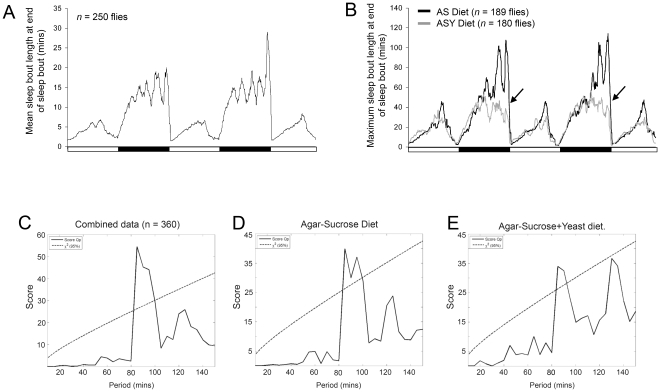
Arousal from sleep is ultradian and disrupted by dietary yeast.The time of day that a male fly aroused from a sleep bout was recorded and the length of that sleep bout was calculated and plotted as a 1-hour running average over 2.5 consecutive days. (A) Data from 250 different male flies from five independent experiments is presented. During the daytime there is no obvious ultradian rhythm of arousal, whereas at night there are several discrete epochs during which flies are more or less likely to arouse from sleep. (B) The effect of the AS (black line) and ASY (gray line) diets upon the ultradian pattern of nocturnal arousal. Data for the maximum length of sleep bouts is presented. Flies fed the AS diet show an ultradian rhythm of arousal, whereas, flies on the ASY diet have similar periodicity ultradian rhythm of arousal but lower peaks of sleep length due to shorter periods of sleep on the ASY diet (arrows). (C) Periodogram analysis of the data combined from all experiments (n = 360 male w1118 flies) established that arousal occurs according to a significant ultradian rhythm with a periodicity of 90 minutes. (D) Periodogram showing a significant ultradian rhythm of nocturnal arousal for male flies fed sucrose only. (E) The periodogram for male flies fed sucrose and yeast extract shows a significant ultradian rhythm of 85 minutes and a trend towards a longer frequency rhythm, of approximately 130 minutes, that does not reach significance. The black and white bar denotes the 12-hour light and dark periods. n = 189 and 180 flies from independent experiments for the AS and ASY diets, respectively.